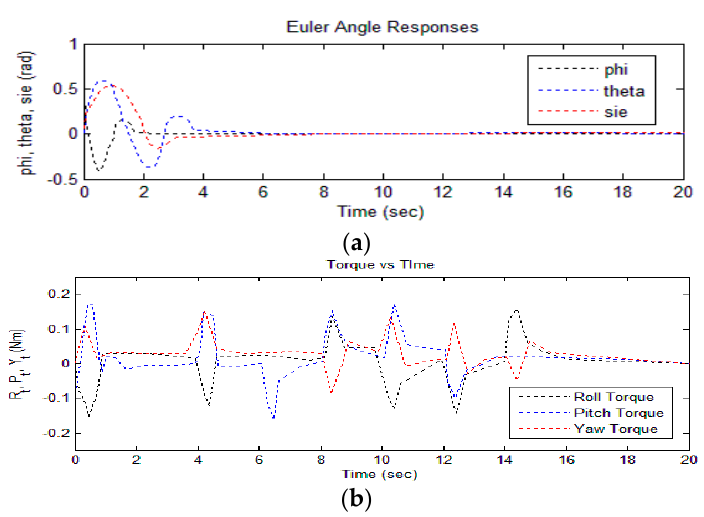
Figure 13. ( a ) Roll, pitch, yaw rate, and Euler angle responses of UAV; ( b ) torque with respect to the Euler angle responses of